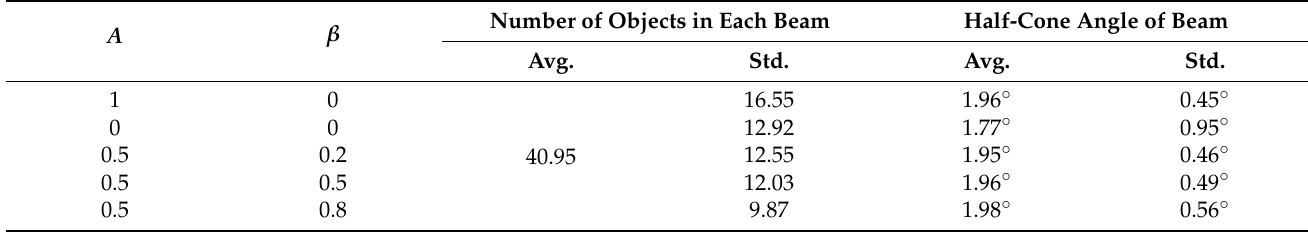
Table 1. Statistic of the impact of α and β on the results.